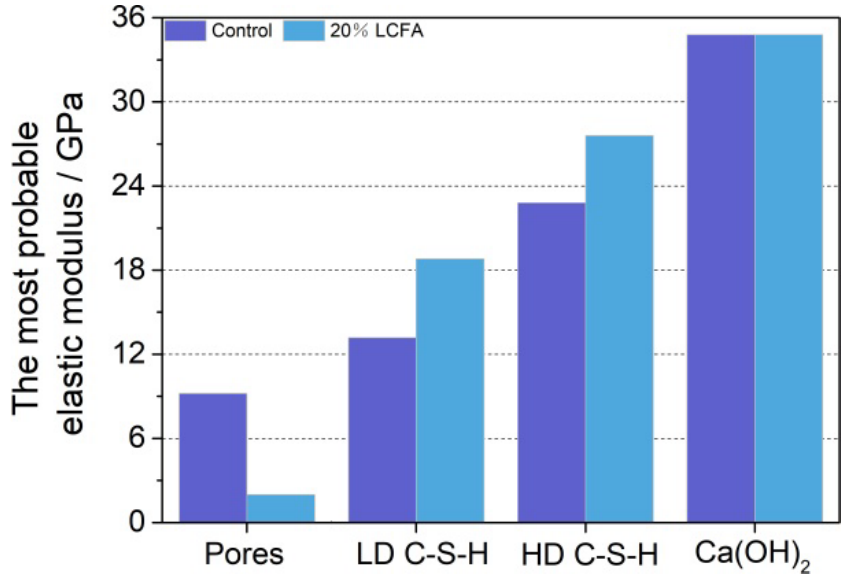
Figure 17. The most probable elastic modulus variation of samples at 28 days.